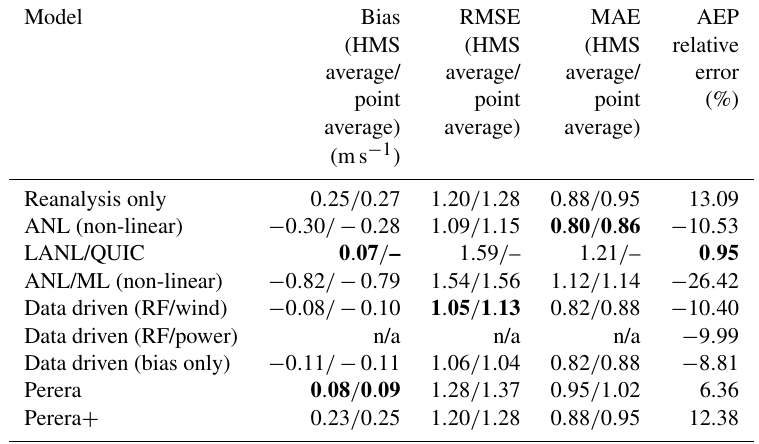
Table 4. Results comparison for IEC Met Tower. Bold values show the results of best performance.